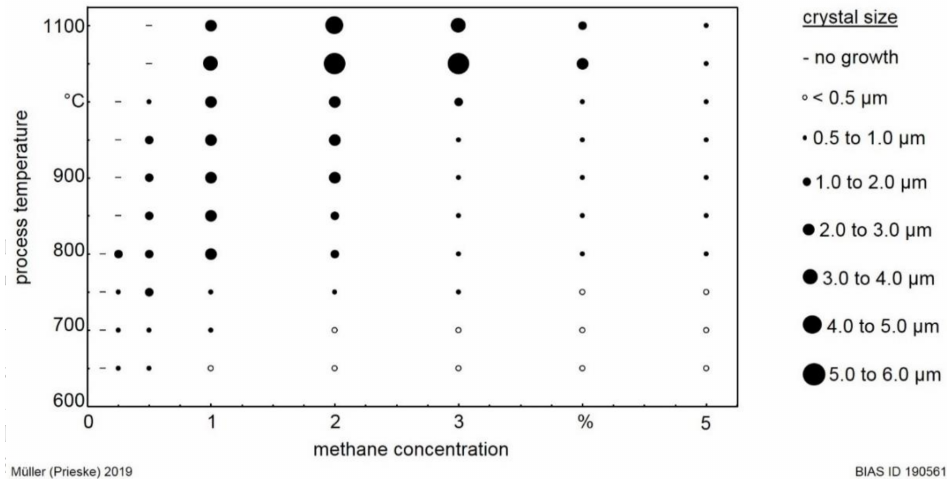
Figure 3. Process window of the LaPlas CVD process with mean crystal sizes of the corresponding coatings as a function of the process temperature and the methane concentration.